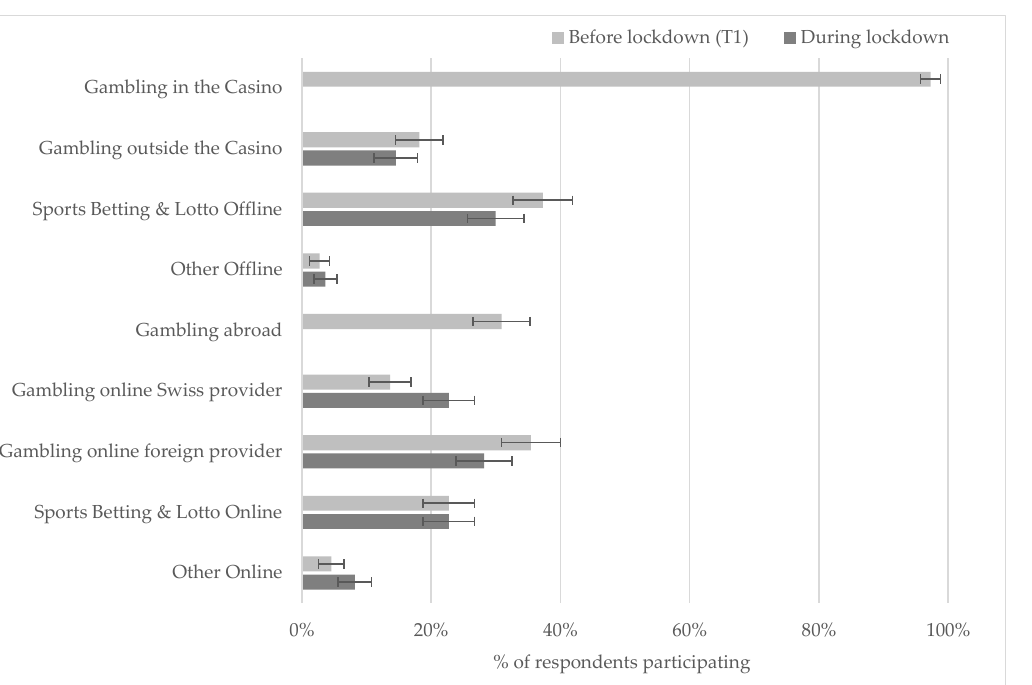
Table 4. Comparison between respondents who gambled and did not gamble during lockdown. Sample Characteristics